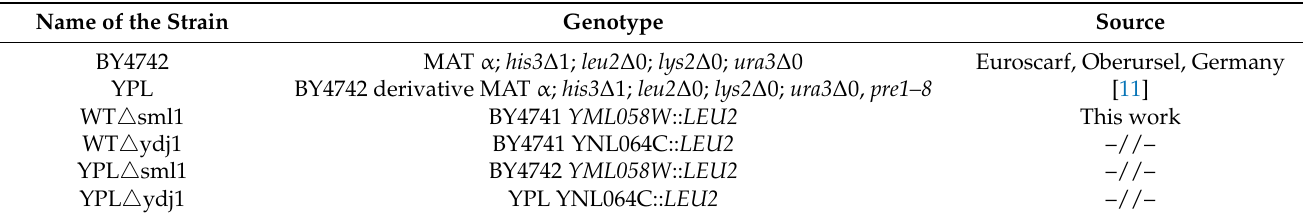
Table 1. Yeast strains used in the